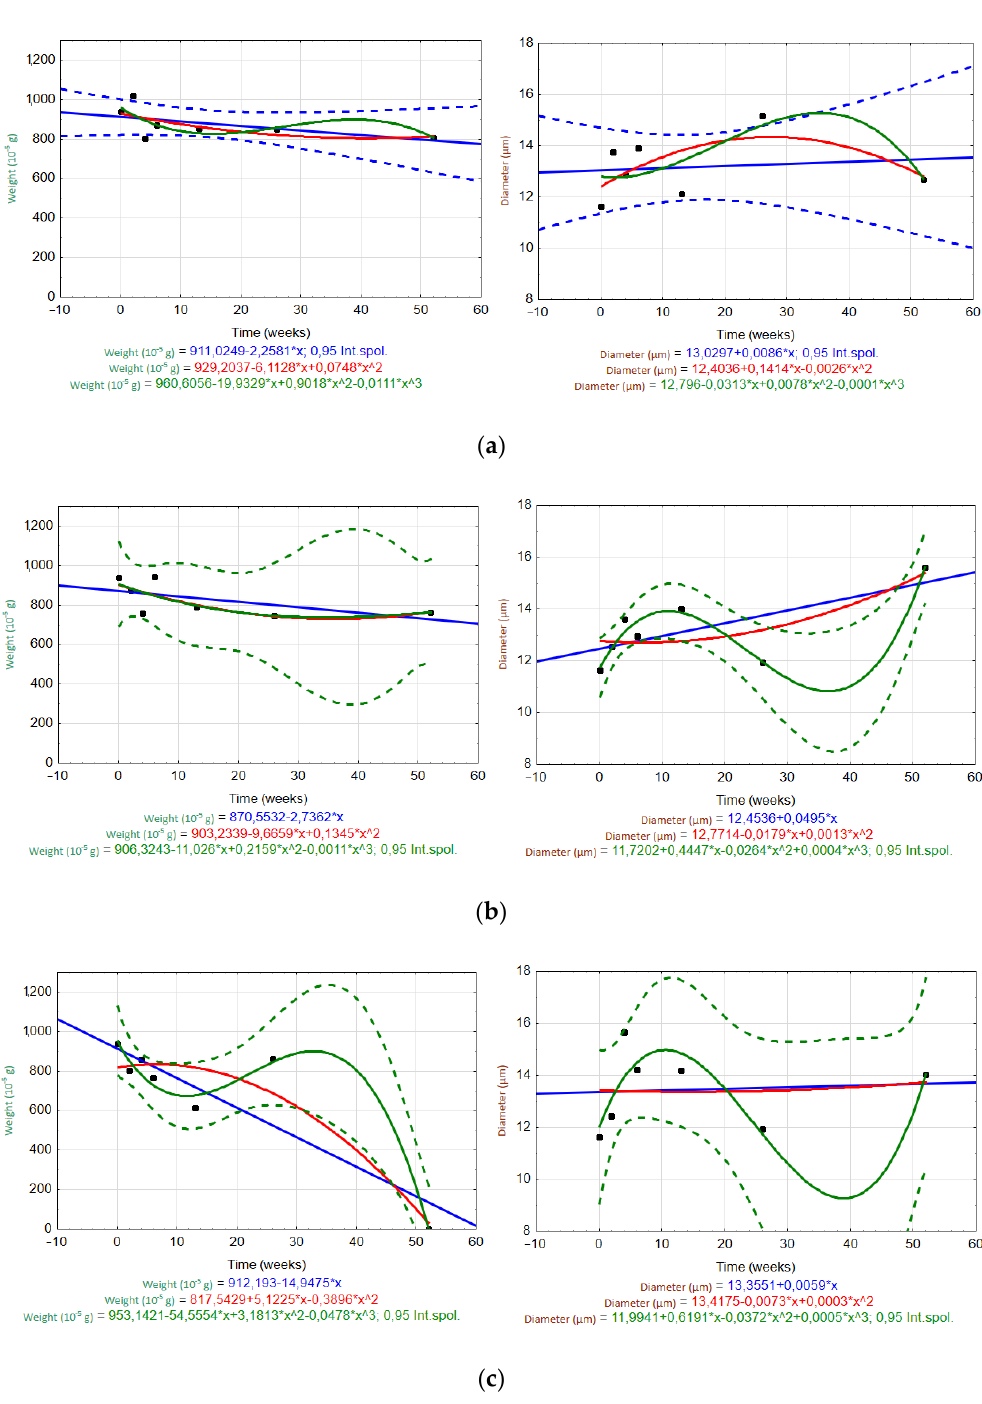
Figure 8. Scatter plots of the temporal trends for the ARGF weight (left) and fiber diameter (right) in different solutions: ( a ) H 2 O, ( b ) Ca(OH) 2 , and ( c ) K 2 SiO 3 (Int.spol. mean confidence interval). For the EGF in H 2 O (Figure 9a), only the linear trend (blue line) may predict the changes in the fiber weight and diameter over time (rate of weight loss was 2.57 × 10 − 5 g/day; rate of diameter increase was 0.01 µm/day). These results show that the ARGFs lost weight at a rate about eight times slower than EGFs, and the diameter increased at a rate about seven times slower than EGFs. The EGF in Ca(OH) 2 (Figure 9b) showed that both the quadratic and cubic trends were suitable for predicting the changes in weight and diameter over time. The same results were observed for the EGF in K 2 SiO 3 (Figure 9c).